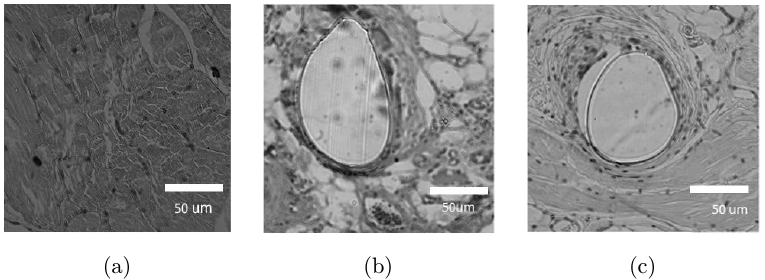
Fig. 2. Confocal microscopy images: (a) normal muscle tissue from control group animal and pathologies in encapsulation area, (b) the substitution of normal tissue by adipose cells, and (c) voids formation.